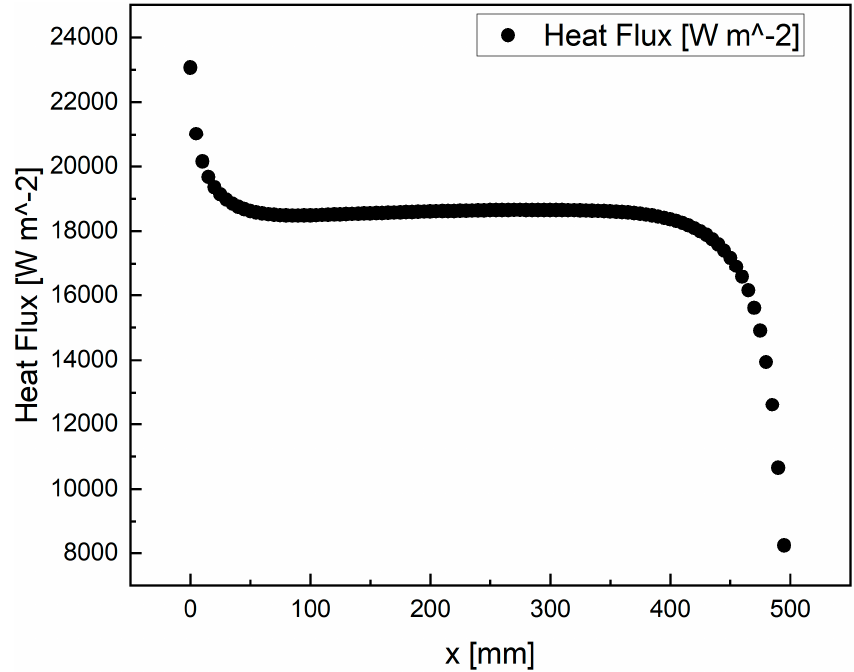
Figure 10. Average heat flux of Tube-3 towards coolant at the heated zone.